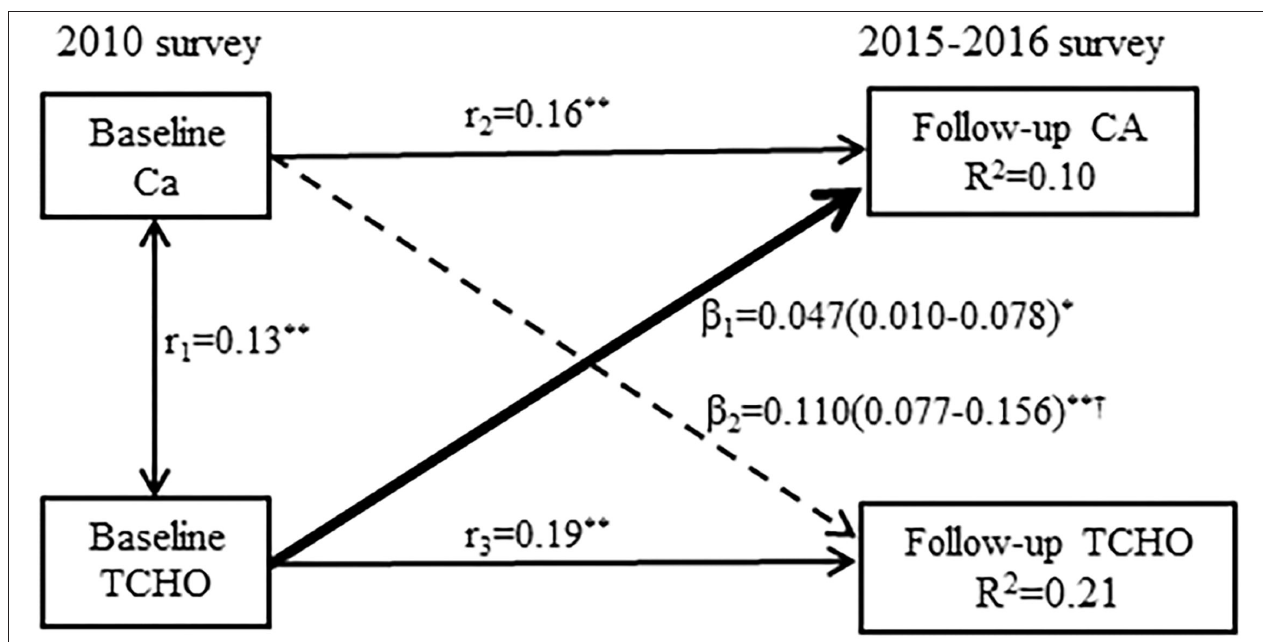
FIGURE 1 | A cross-lagged path analysis of serum calcium and total cholesterol, adjusted for the covariates (covariates such as age, sex, body-mass index [BMI], smoking, alcohol consumption, regular exercise, marriage, caloric intake, family history of cardiovascular disease [CVD], triglyceride [TG], high-density lipoprotein cholesterol [HDL-C], low-density lipoprotein cholesterol [LDL-C], and drug use for hypertension or dyslipidemia) in the total sample ( N = 3,292); β 1 cross-lagged path coefficient from the baseline total cholesterol to follow-up serum calcium, β 2 cross-lagged path coefficient from the baseline serum calcium to follow-up total cholesterol, r 1 r epresents synchronous correlations, r 2 and r 3 represent tracking correlations, R 2 variance explained. ** P < 0.001 for coefficients being different from 0; † difference between β 1 and β 2 for being different from